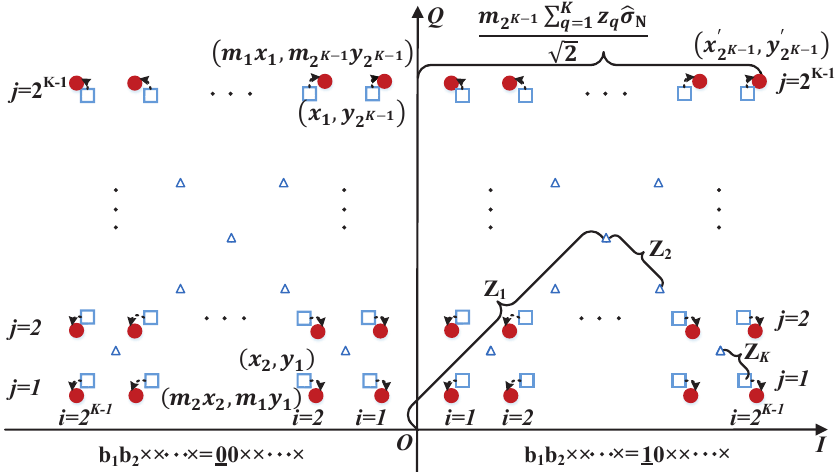
Figure 2. The demonstration of SC-A in the first and second quadrants. Triangle: the intermediate points of superposition signals in constellation before SC-A; square: the points of the SC before SC-A; circle: the points of the SC after